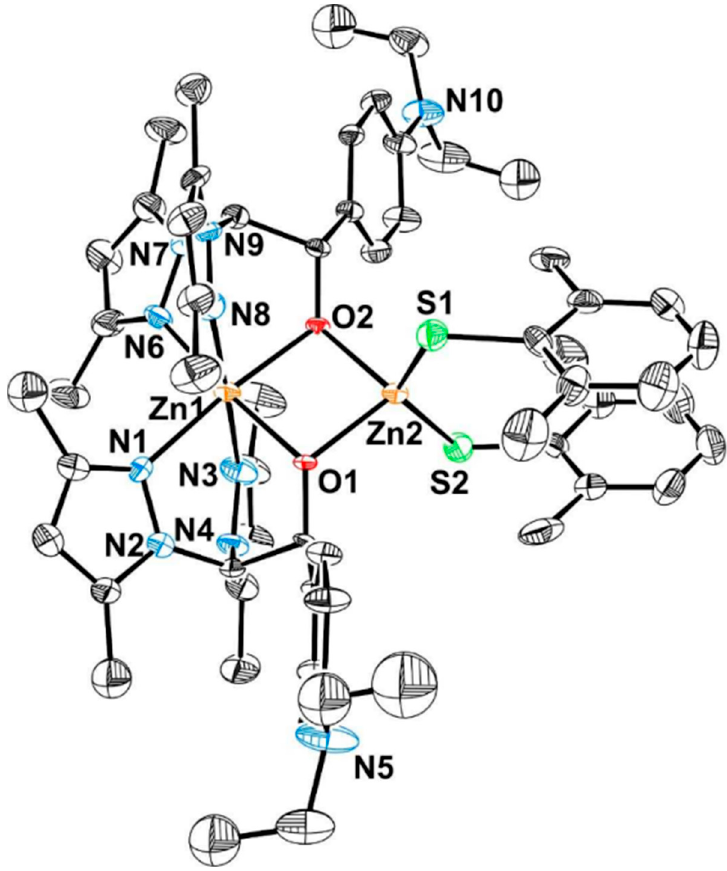
Figure 1. ORTEP view of the S , S enantiomer of [Zn(bpzaepe) 2 {Zn(2,6-Me 2 C 6 H 3 S) 2 }] ( 4 ). Hydrogen atoms have been omitted for clarity. Thermal ellipsoids are drawn at the 30% probability level.